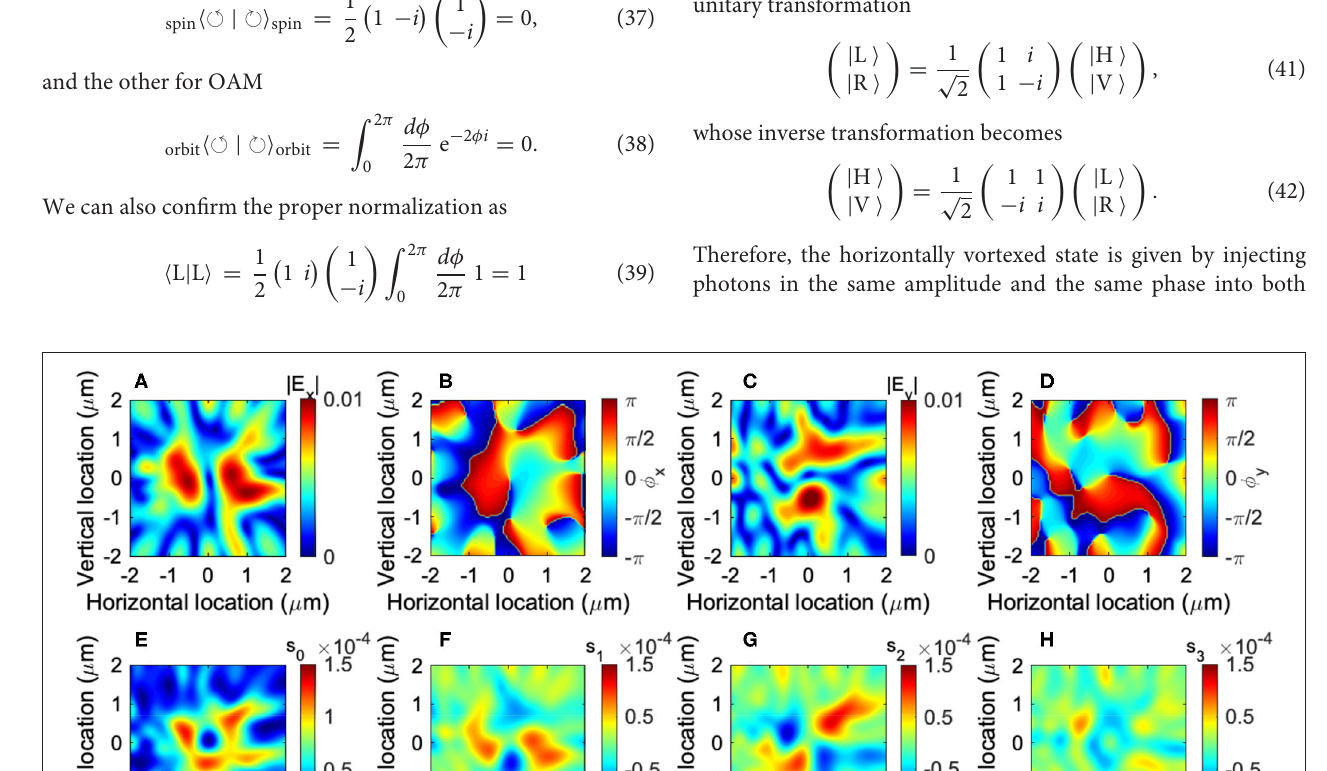
Frontiers in Physics |